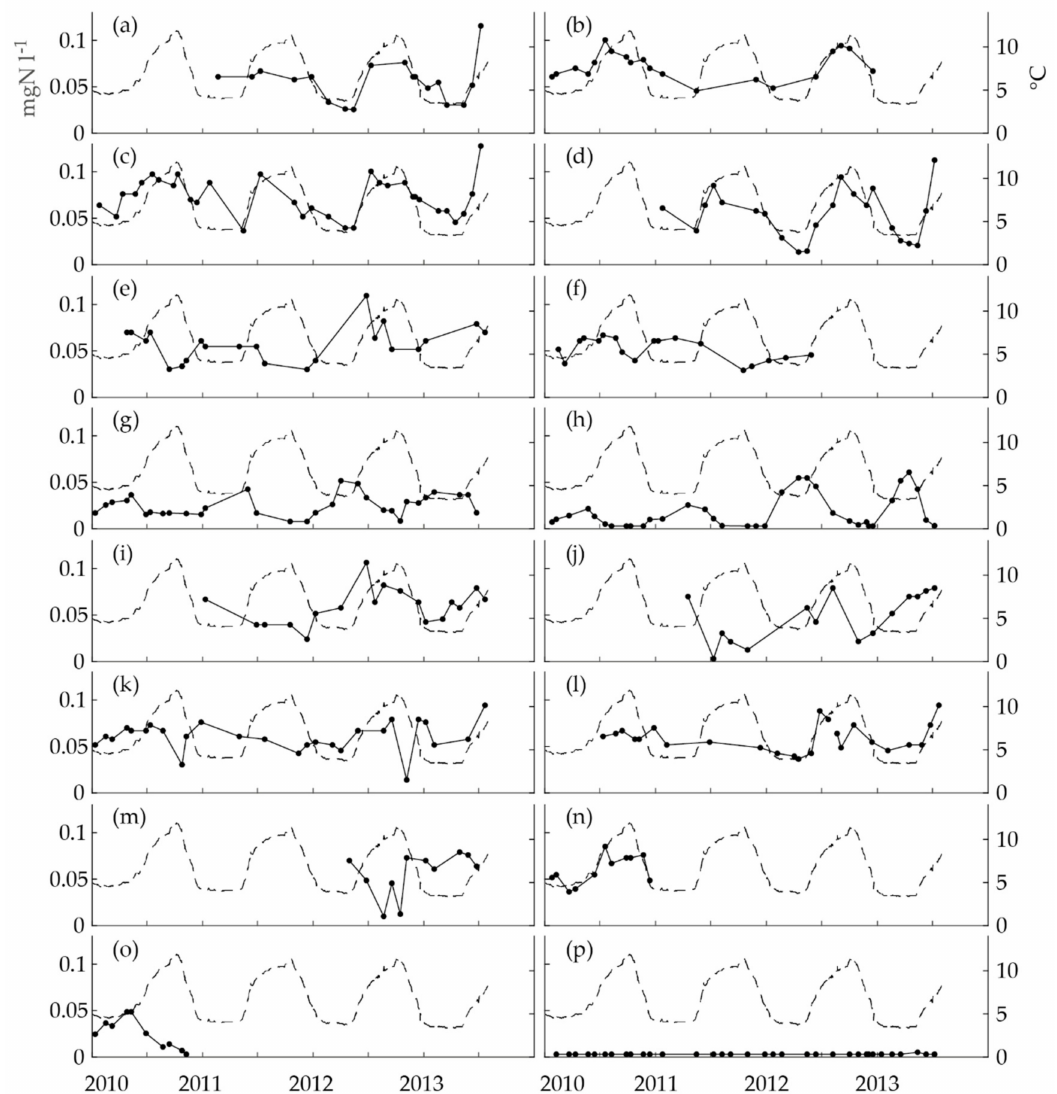
Figure 2. The time series of nitrite concentrations in the drinking water distribution system (DWDS) in the obligatory monitoring data collected between January 2010 and July 2013 (the unbroken line with dots, the left y -axis: one dot represents one analysis) and temperature at the WTP (the dashed line, the right y -axis) for ( a ) Sheltered Home M, ( b ) Sport Center M, ( c ) Gas Station R, ( d ) Shopping